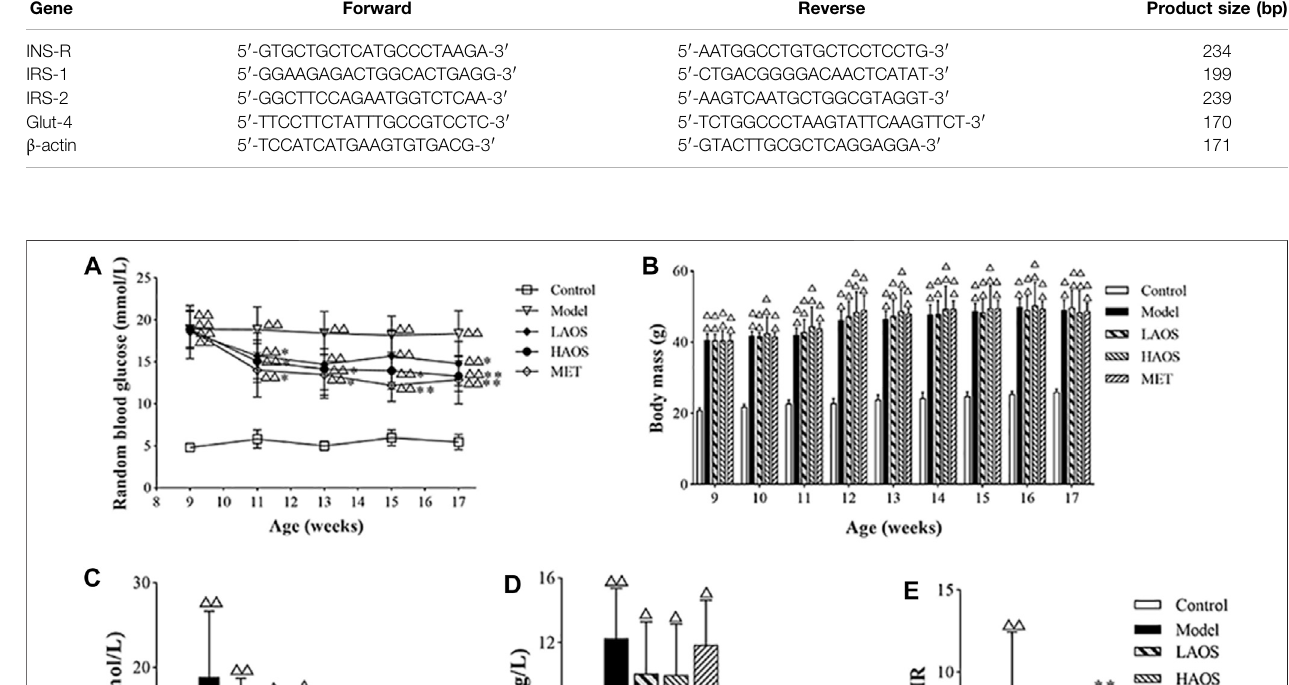
100 ° C. Atomization was performed at 400 ° C. The fl ow rate of desolvation reached 600 L/h. Leucine-enkephalin (leu-enk) was